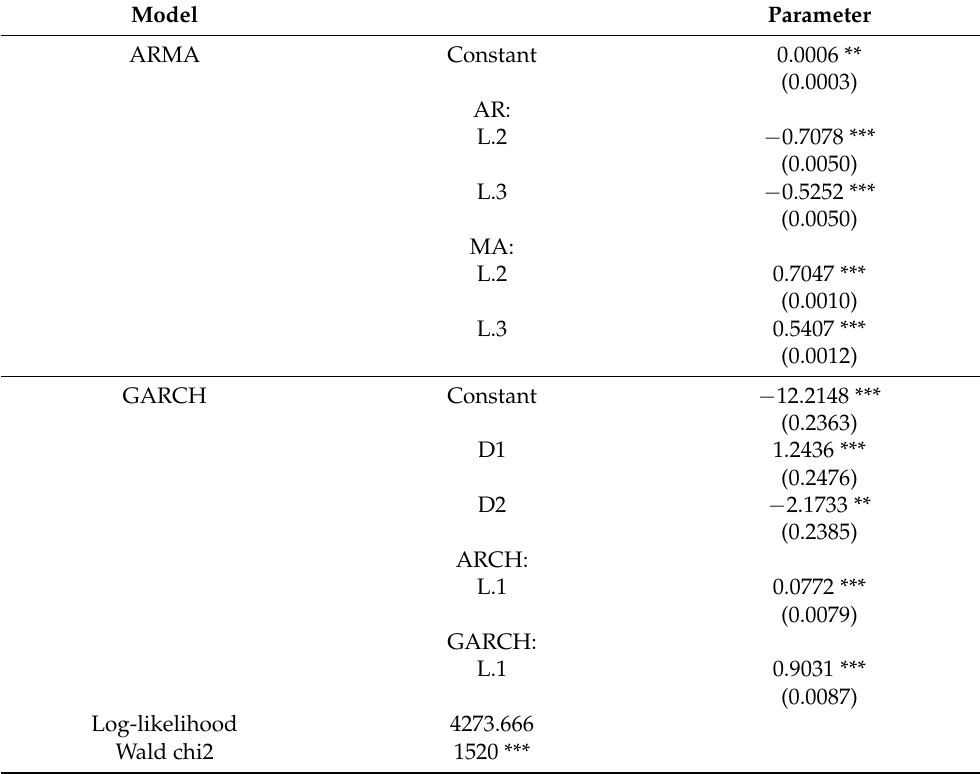
Table 4. GARCH (1, 1) model